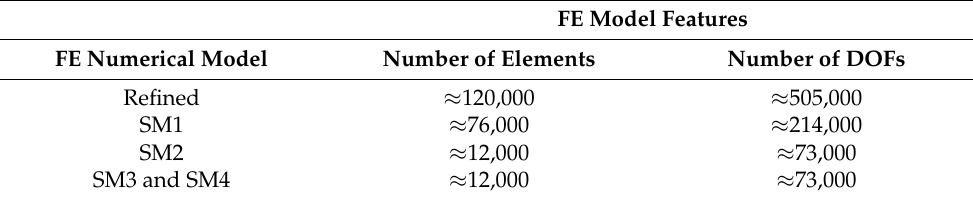
Table 4. Summary of the computational cost of the Refined and SM1-to-SM4 simplified numerical models (ABAQUS) in terms of the total number of elements and DOFs required to reproduce the nominal geometry of the examined